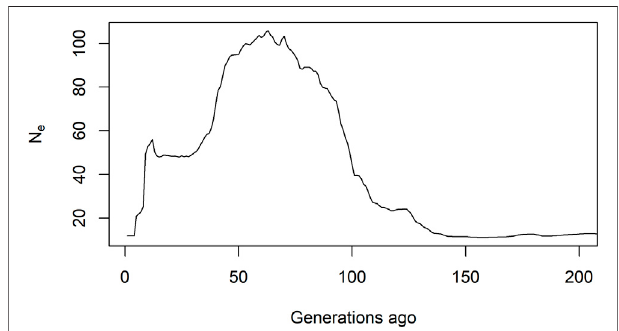
FIGURE 4 | Estimates of historical N e